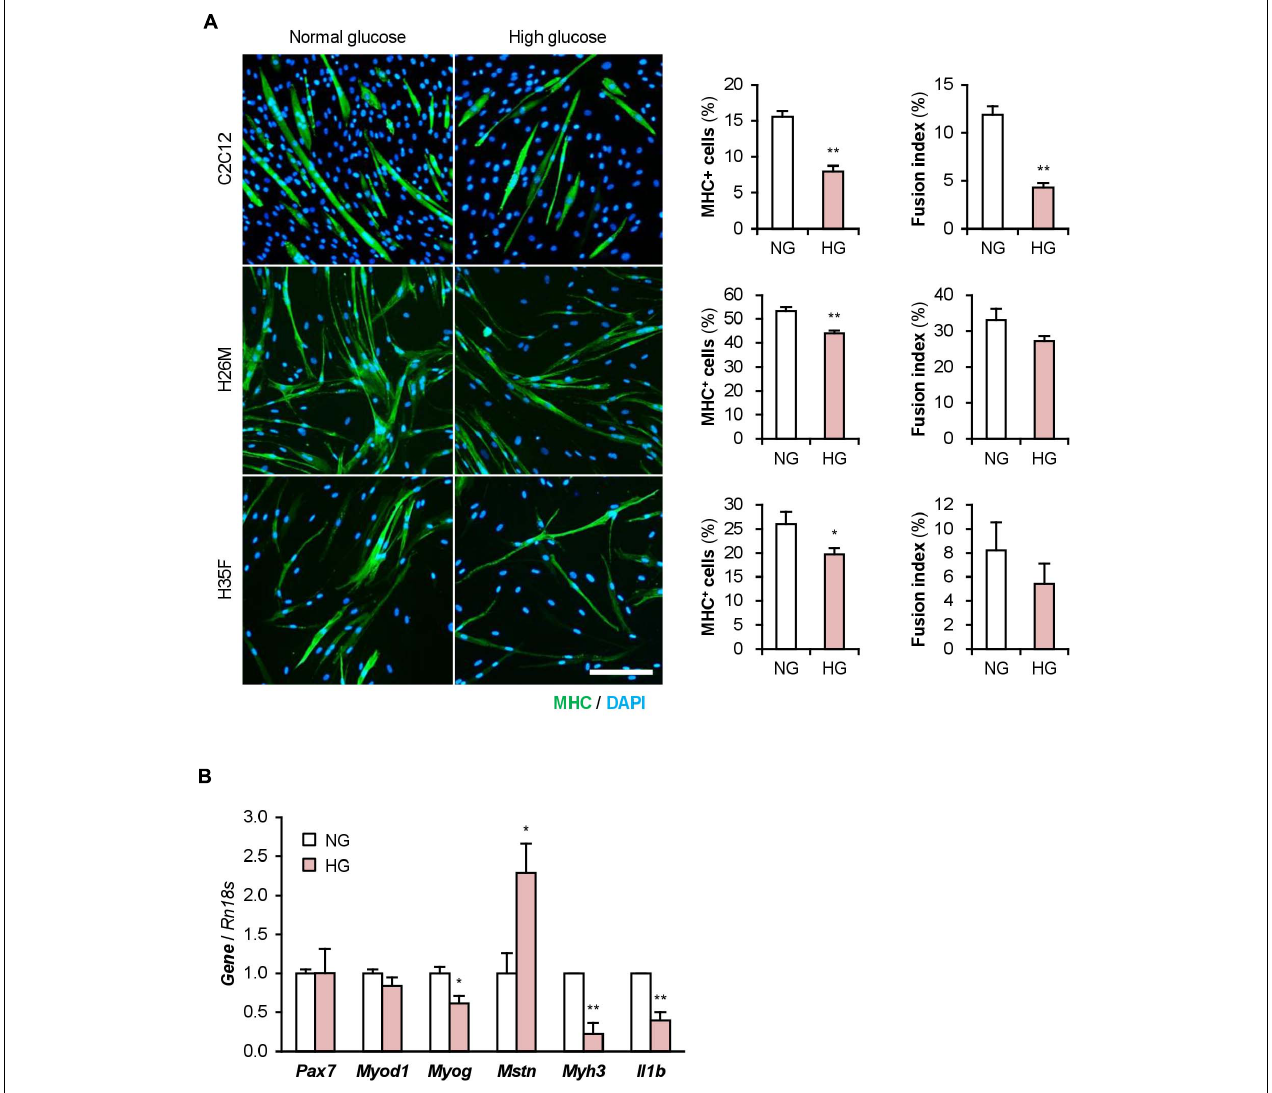
FIGURE 5 | High glucose concentration deteriorates myoblast differentiation. (A) Representative immunofluorescent images of the C2C12, H26M, and H35F myoblasts differentiated in DIM-NG or -HG. Scale bar, 200 µ m. Ratio of MHC + cells and multinuclear myotubes were quantified. * p < 0.05, ** p < 0.01 vs. NG (Student’s t -test); n = 4–6. (B) qPCR results of myogenic gene expression in the C2C12 cells differentiated in DIM for 1 day. Mean value of NG group was set to 1.0 for each gene. * p < 0.05, ** p < 0.01 vs. NG (Student’s t -test); n =